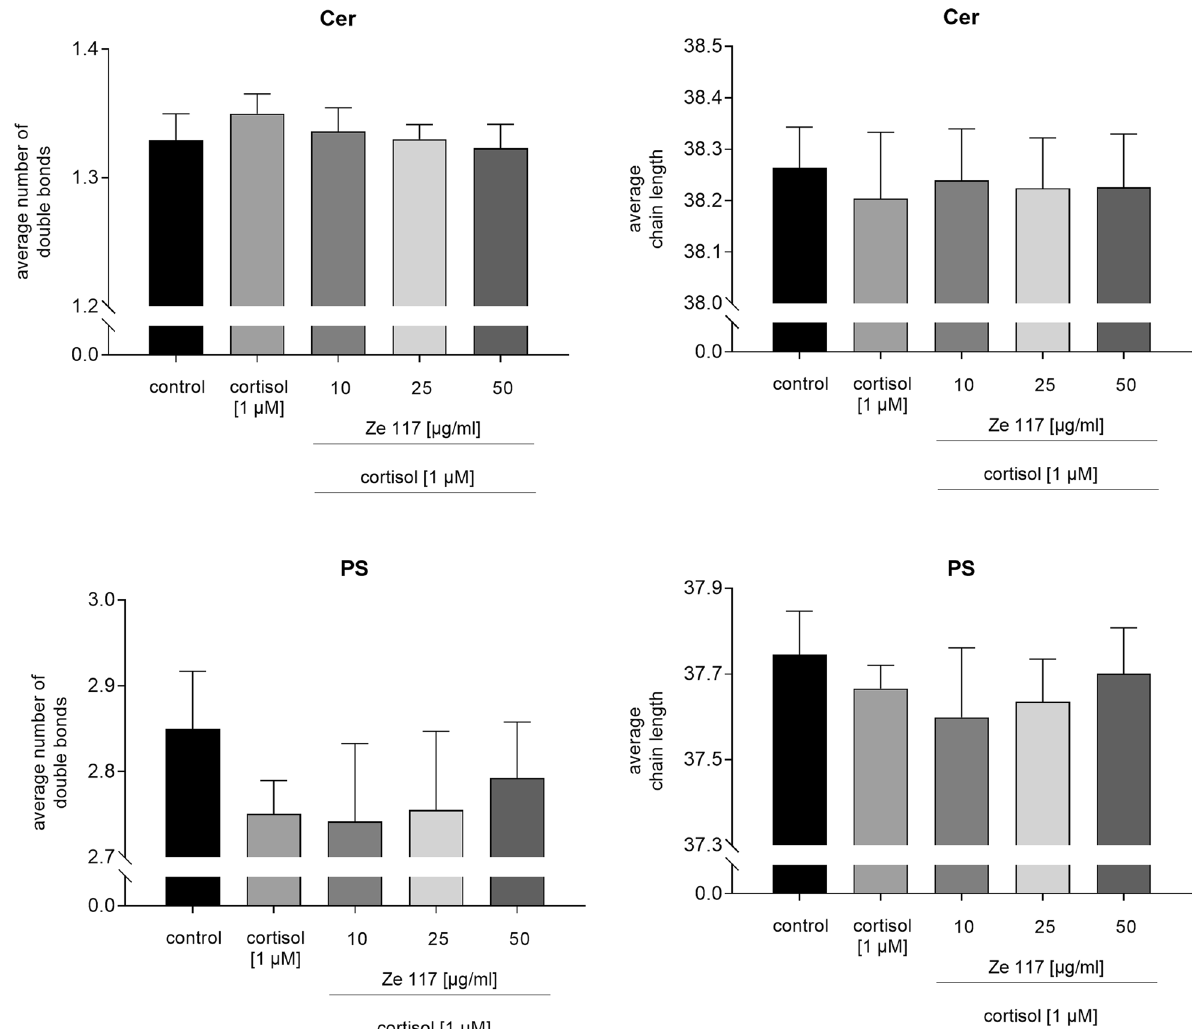
Fig. 7 Average chain length and average number of double bonds of the lipid classes of ceramides (Cer) and phoshpatidylserines (PS) after cortisol and cortisol/Ze 117 preincubation, respectively. For statistical evaluation the cortisol condition was compared to the control. Average chain length and average number of double bonds of cortisol/Ze 117 pre-treated cells were compared with the cortisol condition. *Marked values are significantly different from corresponding control with p < 0.05 (**p < 0.01, ***p < 0.001, ****p < 0.0001) determined by one-way ANOVA (n followed by Holm-Šídák